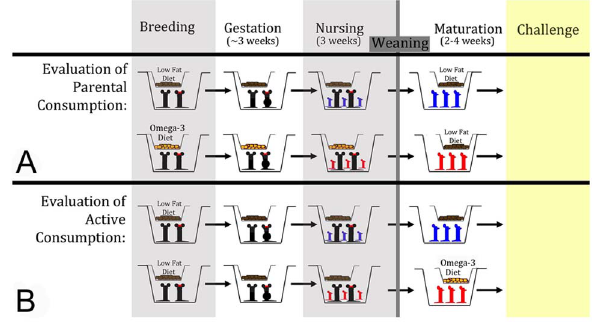
Figure 1. Summary of study design. (a) For experiments evaluating the effects of parental diet, littermate mice were placed on either Low Fat or high omega-3 formulations one day prior to being placed in breeding cages. Breeder mice were maintained on the different diets